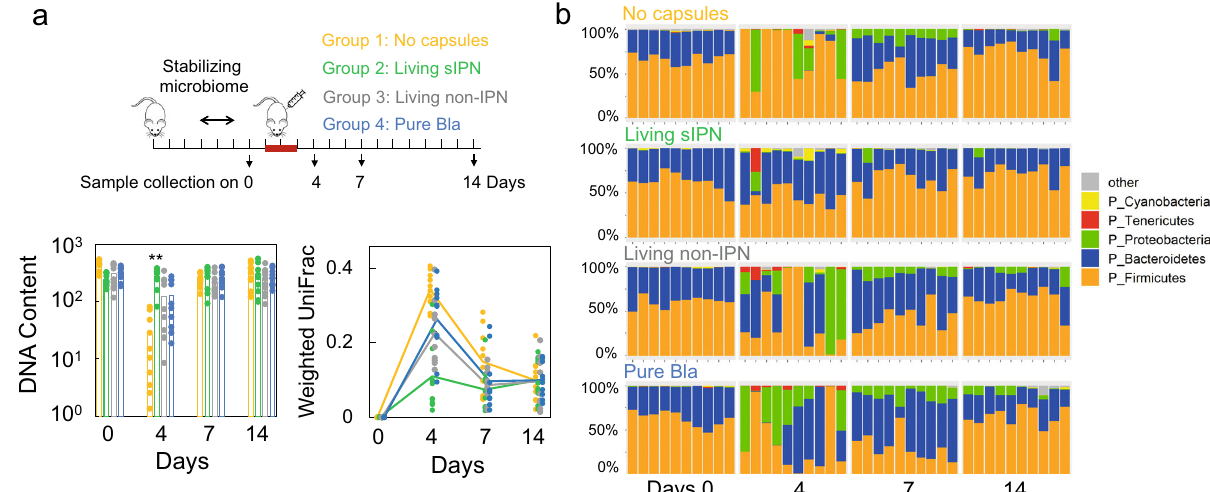
Fig. 4 Living Bla sIPN capsules minimized antibiotic-mediated perturbations of the gut microbiome in mice. a Living Bla sIPN capsules provided the most potent protection of the gut microbiome from antibiotic-mediated perturbations (top: experimental setup; bottom: experimental data). Forty mice were separated into four groups and kept in the facility for 1 week to stabilize the gut microbiome. Fecal samples were collected on day 0 and used as reference point to evaluate the disturbance to the microbiome. The treatment was given from day 1 to 3. On each day, living Bla sIPN capsules, living non- IPN capsules producing Bla or pure Bla capsules were administered to groups 2 – 4, respectively. After 1 h, 5 mg ampicillin (100 μ L) was injected into each mouse through the tail vein for all four groups. Fecal samples from 40 mice were collected on days 0, 4, 7, 14 for DNA quanti fi cation and 16S rDNA sequencing. The left panel shows the DNA content (ng DNA per mg fecal matter). Each dot represents an individual mouse, and the bar represents the average value ( n = 10). The right panel shows the weighted UniFrac distance between the gut microbiome at days 4, 7, 14, and the reference point (day 0) as analyzed by QIIME2 (see “ Methods ” ). The weighted UniFrac distance takes into account both phylogenetic lineages and relative abundance of two samples and is commonly used as the distance metric for microbial communities. The line represents the mean value ( n = 10). On day 4, living sIPN capsules exhibited the most potent protection in comparison to the other three groups, in terms of maintaining the total DNA content and microbiome composition (** p < 0.01 ( p = 10 − 5 , 0.005 and 0.003 for group 2 compared with groups 1, 3, and 4 on day 4), determined by the two-sided Student ’ s